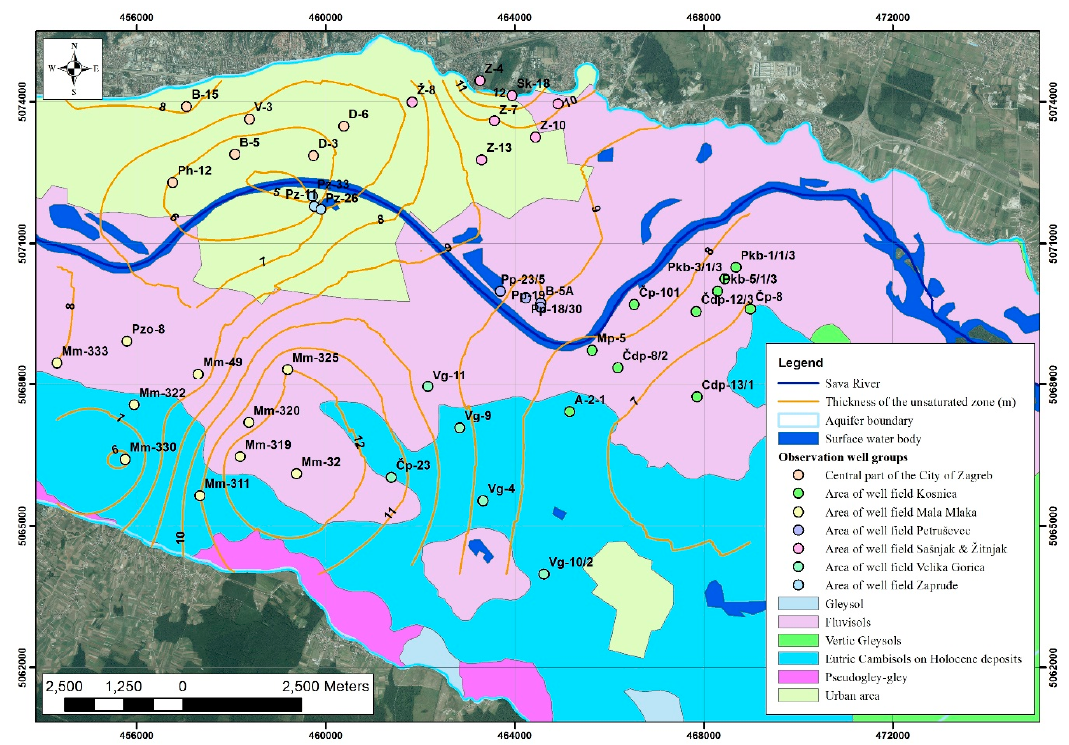
Figure 2. Maximum thickness of the unsaturated zone and soil types of the Zagreb aquifer.